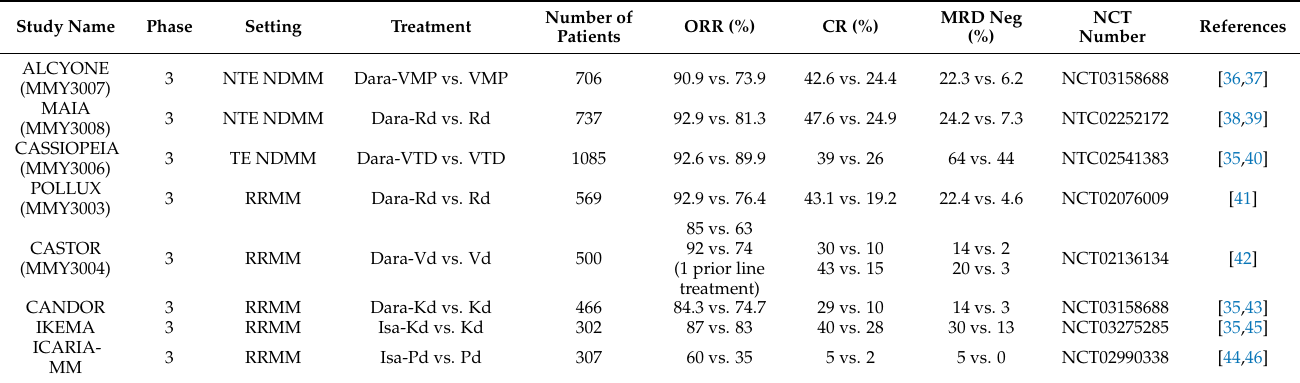
Table 1. Selected trials of daratumumab and isatuximab in